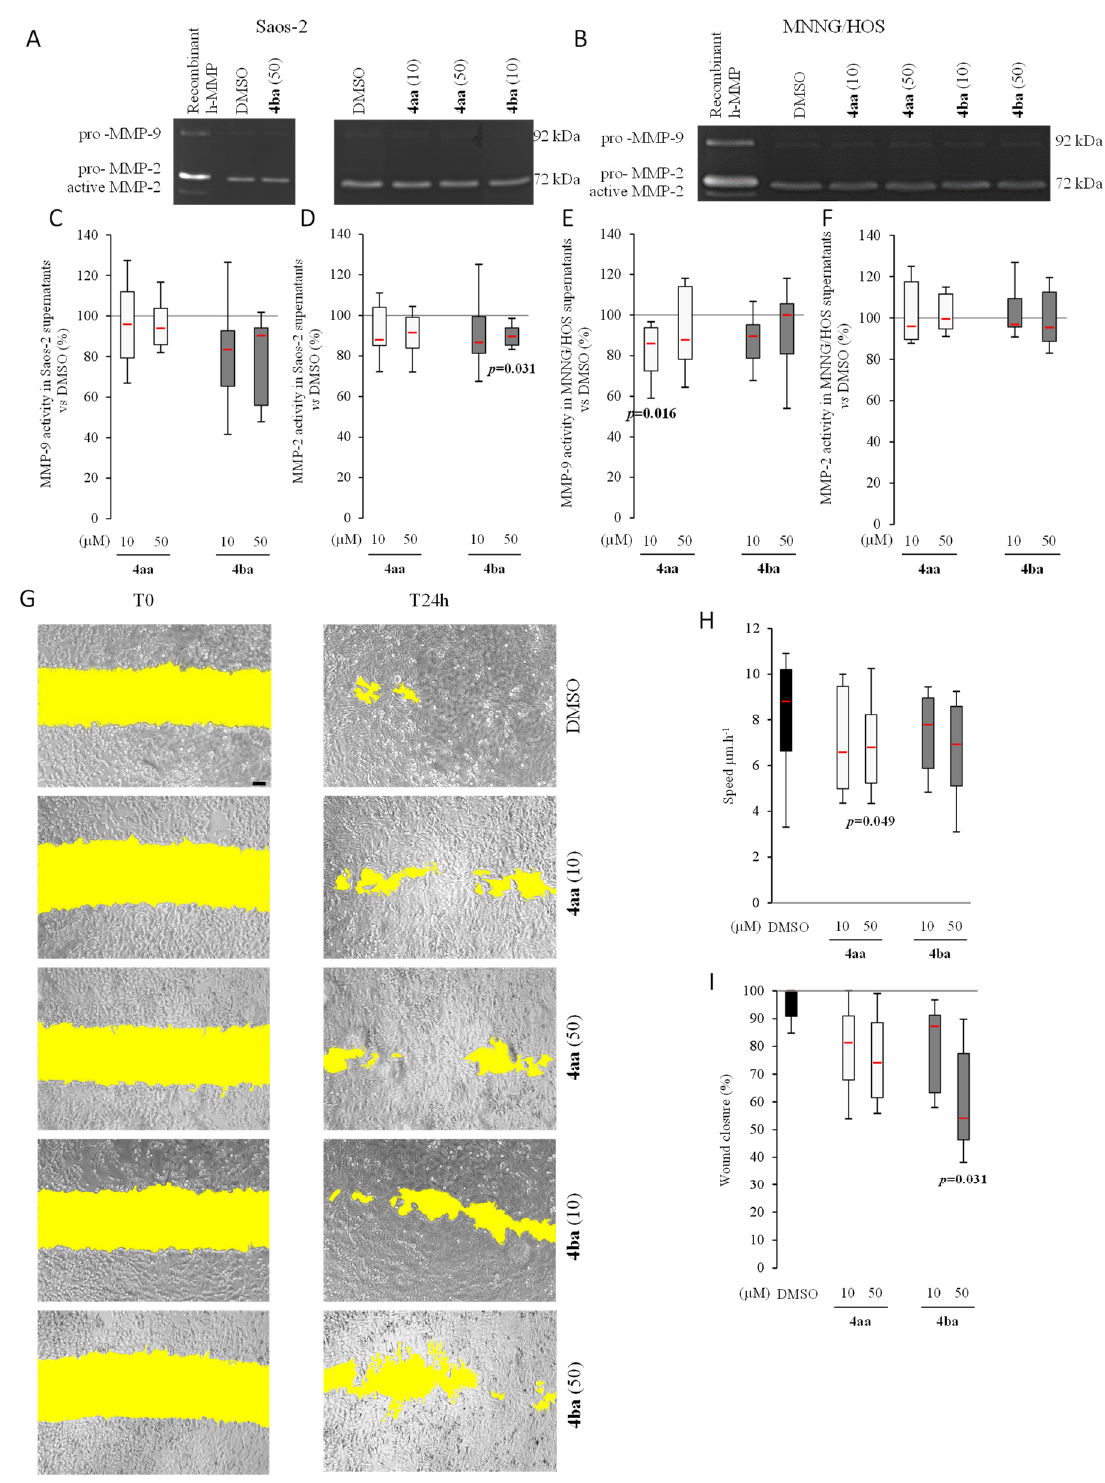
Figure 7. Pyridazinone scaffold-based molecules decrease osteosarcoma cell migration capability in vitro. Representative photography of gelatin zymogram of Saos-2 ( A ) and MNNG/HOS ( B ) culture supernatants. Saos-2 MMP-9 ( C ) and MMP-2 ( D ) activity quantification versus DMSOS. MNNG/HOS MMP-9 ( E ) and MMP-2 ( F ) activity quantification versus DMSO. Representative fields of MNNG/HOS migration at T0 and T24h ( G ); wound area evidenced in yellow. Scale bar = 100 µm. Quantification of cell migration speed ( H ) and wound closure percentage ( I ). n = 7. p -values are given relative to DMSO on box-plots.